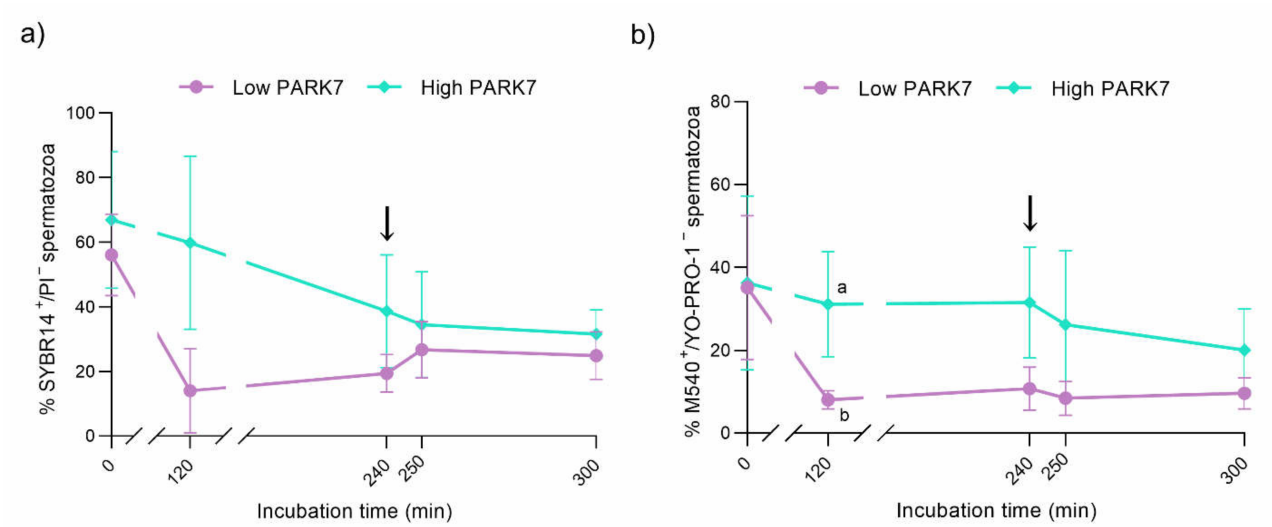
Figure 4. Percentages of viable sperm (SYBR14 + /PI − population) ( a ) and viable sperm with high lipid membrane disorder (M540+/YO-PRO-1- population) ( b ) during in vitro capacitation and acrosomal exocytosis induced by progesterone (300 min). The black arrows indicate the addition of progesterone at a final concentration of 10 µ g/mL (240 min). Data are represented as means ± SD. Different letters indicate significant differences ( p < 0.05) between sperm samples containing high and low relative levels of